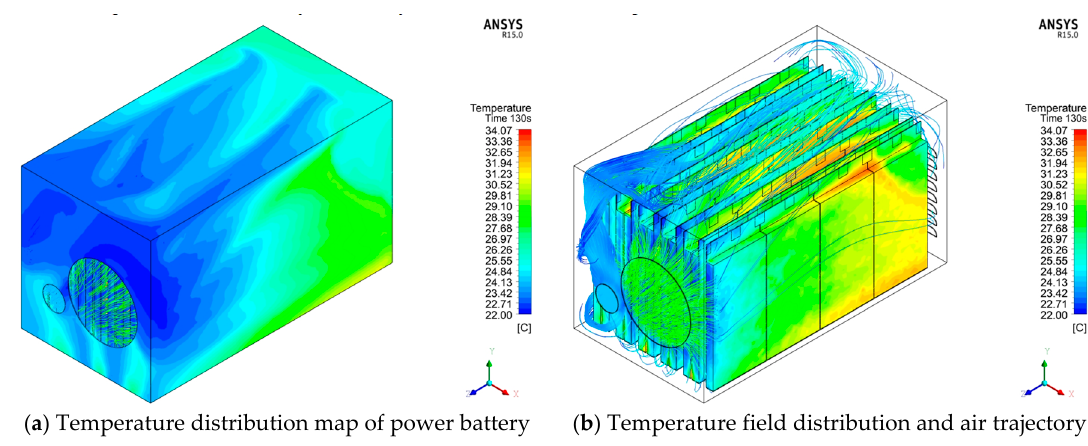
Figure 2. Distribution diagram of cyclic durable discharge condition (130 s).